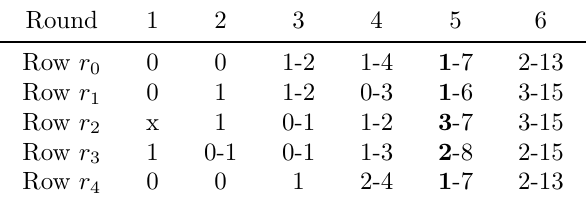
Table 5: Lower and upper bounds on the number of e i variables appearing in each product (Corollary 1) of the coefficient of any 2 r − 1 -degree monomial at Round r